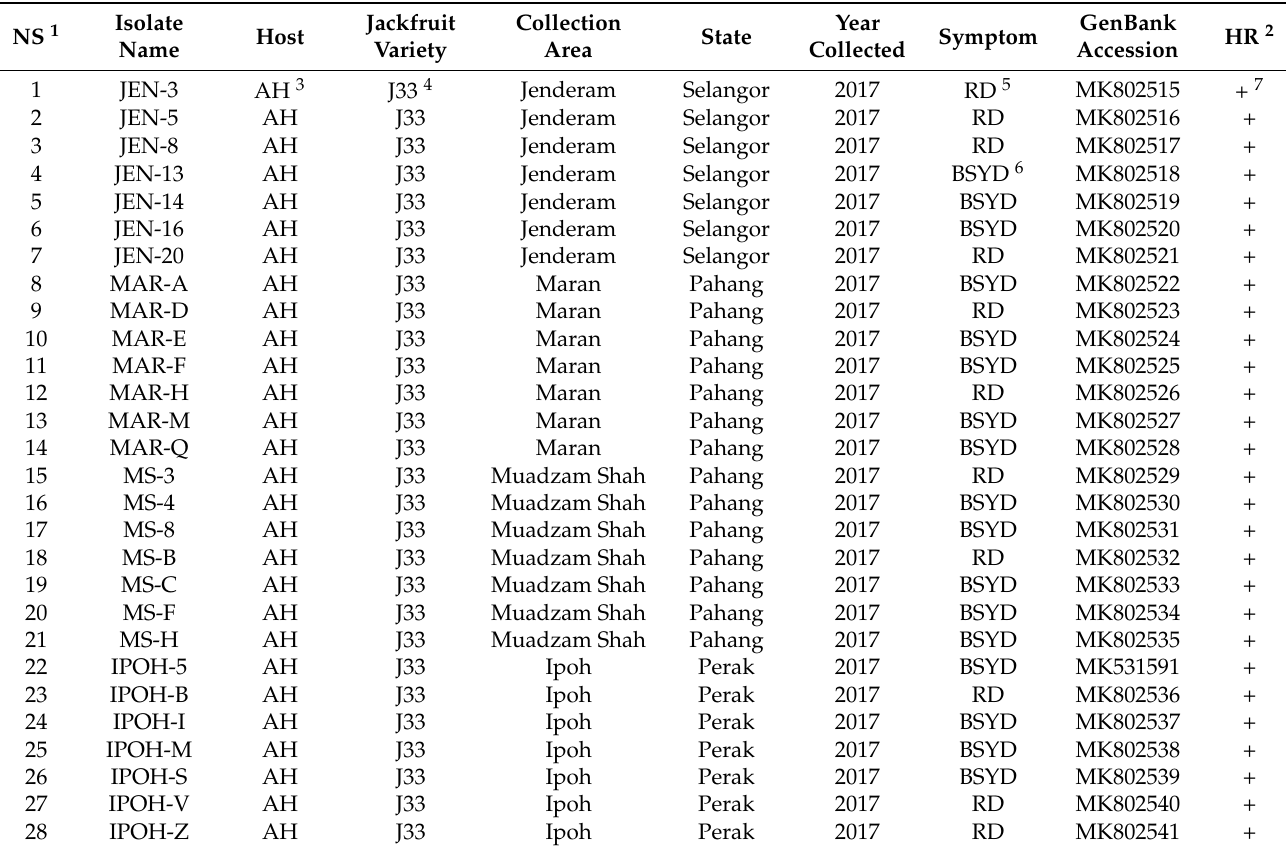
Table 1. Pantoea stewartii subspecies stewartii isolates used in this study ( n = 28)